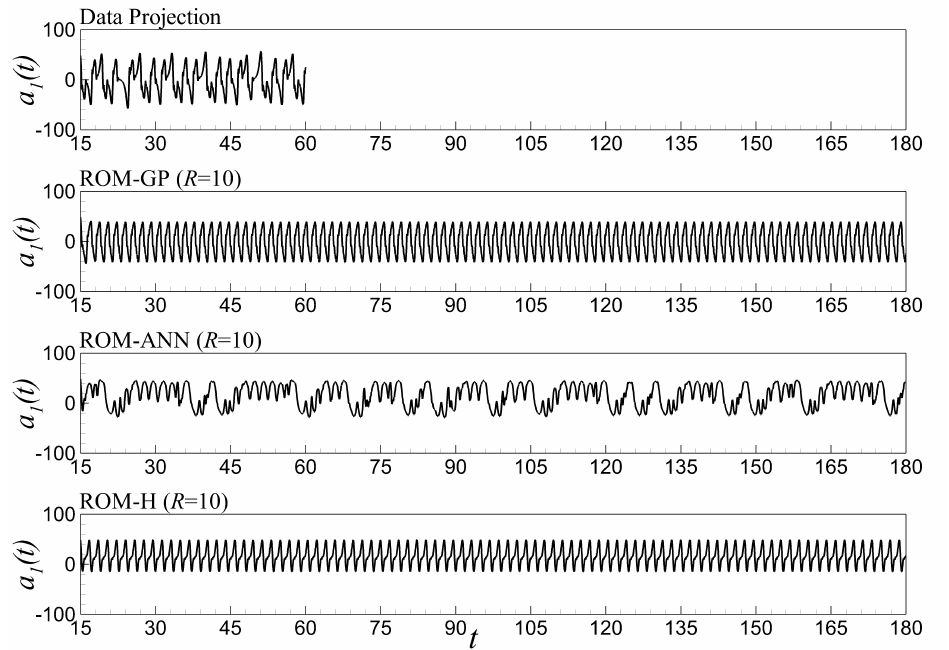
Figure 21. Forecasting of temporal mode evolution of a 1 ( t ) for Re = 25. Note that ROMs are trained by the data snapshots obtained between t = 15 and t =